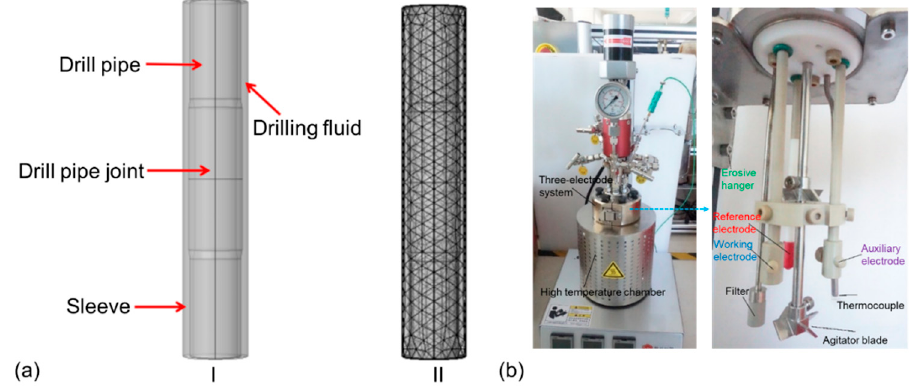
Figure 1. ( a ) The constructed model and meshing strategies for computational domain of drill pipe. ( b ) The test device of the erosion and corrosion resistance in this work.